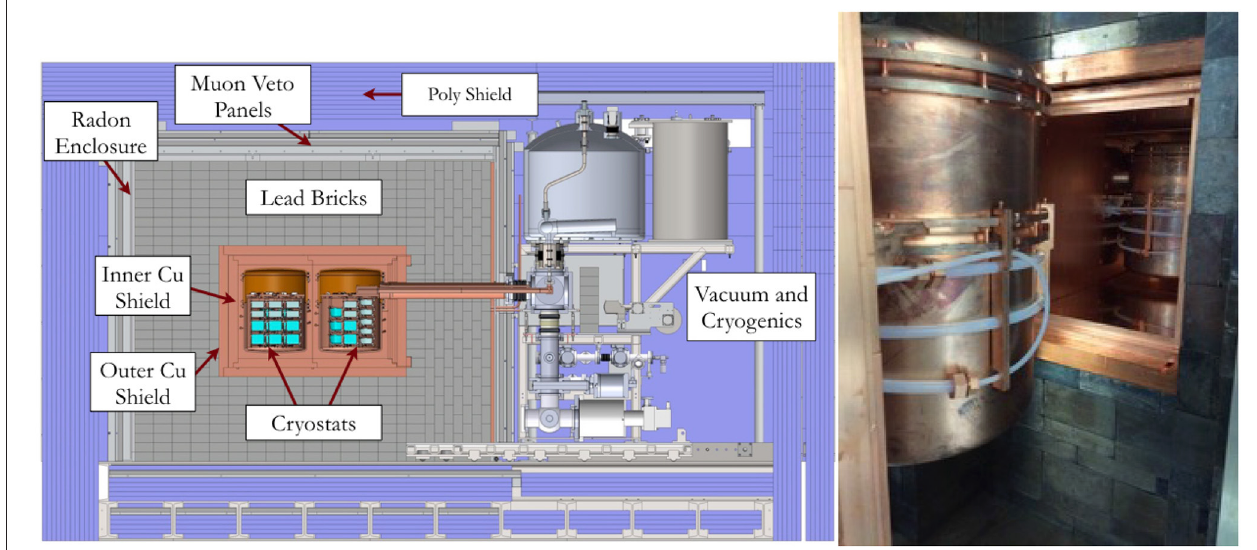
FIGURE 5 | (Left) The shield concept for the M AJORANA D EMONSTRATOR . (Right) A photograph of one cryostat ready for insertion into the shield with the other, already installed, visible in the background. Figure and photo courtesy of the M AJORANA Collaboration.